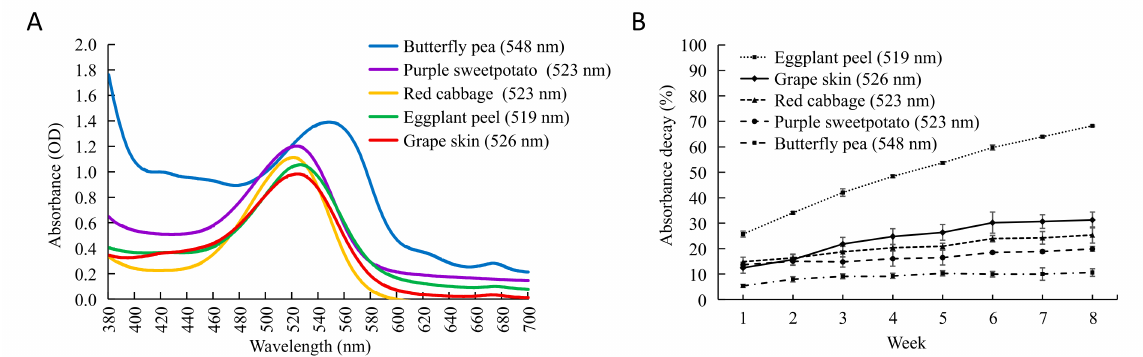
Figure 1. Absorption spectrum scanning ( A ) and the percent of absorbance decay ( B ) for the anthocyanin extracts from blue flowers of butterfly pea and four other common fruits and vegetables. The wavelength value in the bracket indicates the λ max in ( A ) and the measurement wavelength in ( B ) for each plant material.